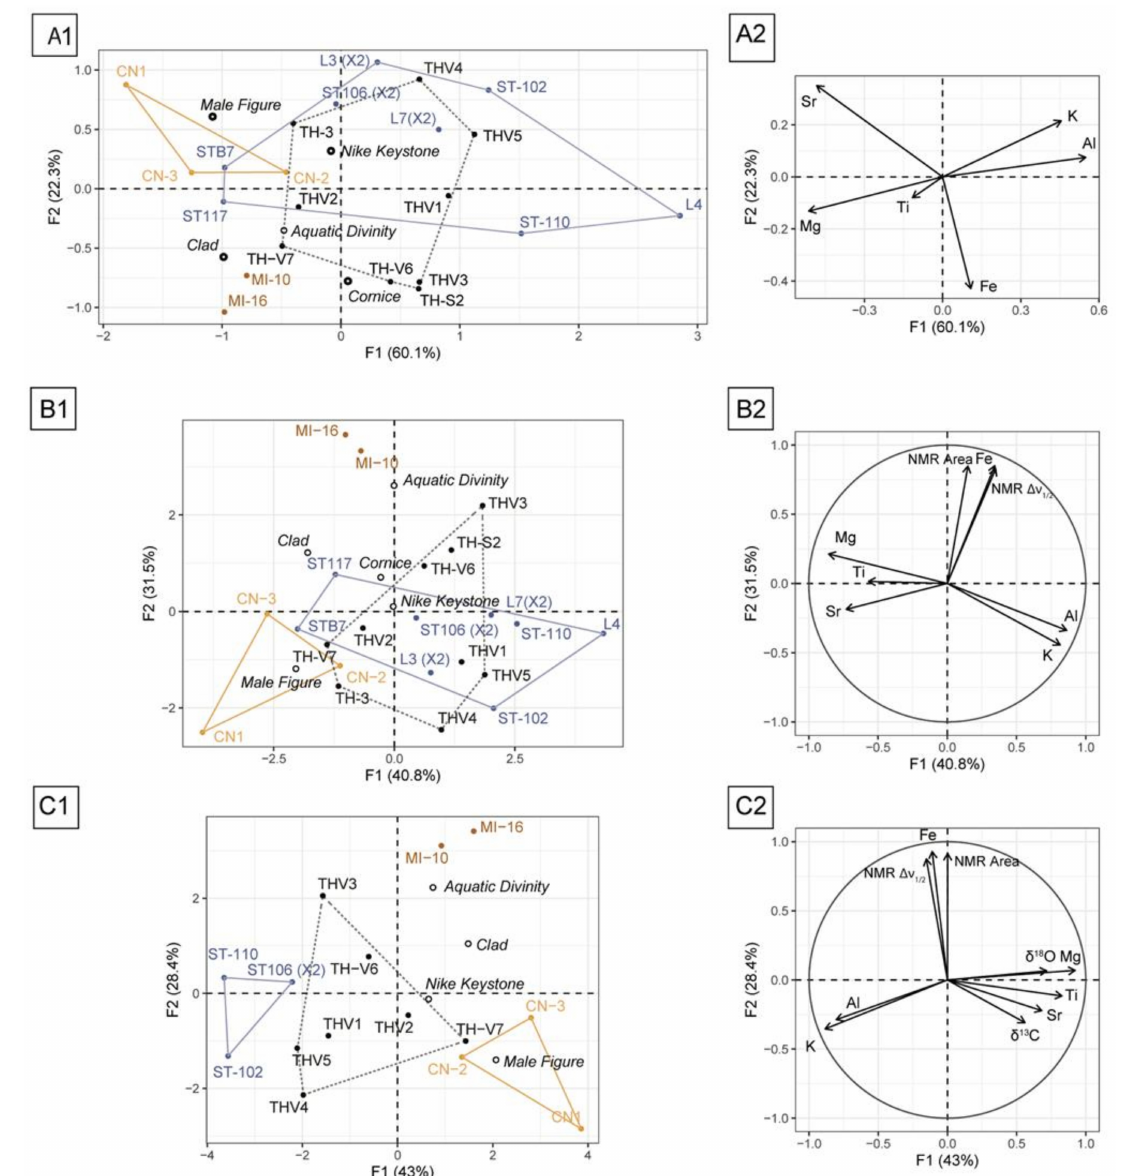
Figure 6. Principal component analysis (PCA) of marble data. ( A ) Non-standardized PCA of log- transformed ICP-OES data. ( B ) Standardized PCA of log-transformed ICP-OES data and 13 C NMR. ( C ) Standardized PCA of log-transformed ICP-OES data, 13 C NMR, and isotopic data. (1) Individuals factor map. (2) Variables factor